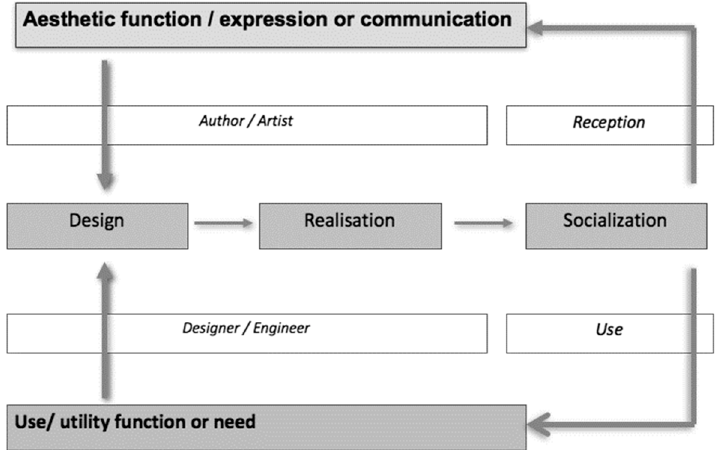
Figure 1. The theoretical “design–realization–socialization” model (Didier and Leuba 2011). This model suggests two discrete professional approaches: the approach of the au- thor/artist, who creates an object with an aesthetic function corresponding to an expression or communication; and the approach of the designer/engineer, who designs an object with a utility function intended to satisfy a purpose or need (Didier and Leuba